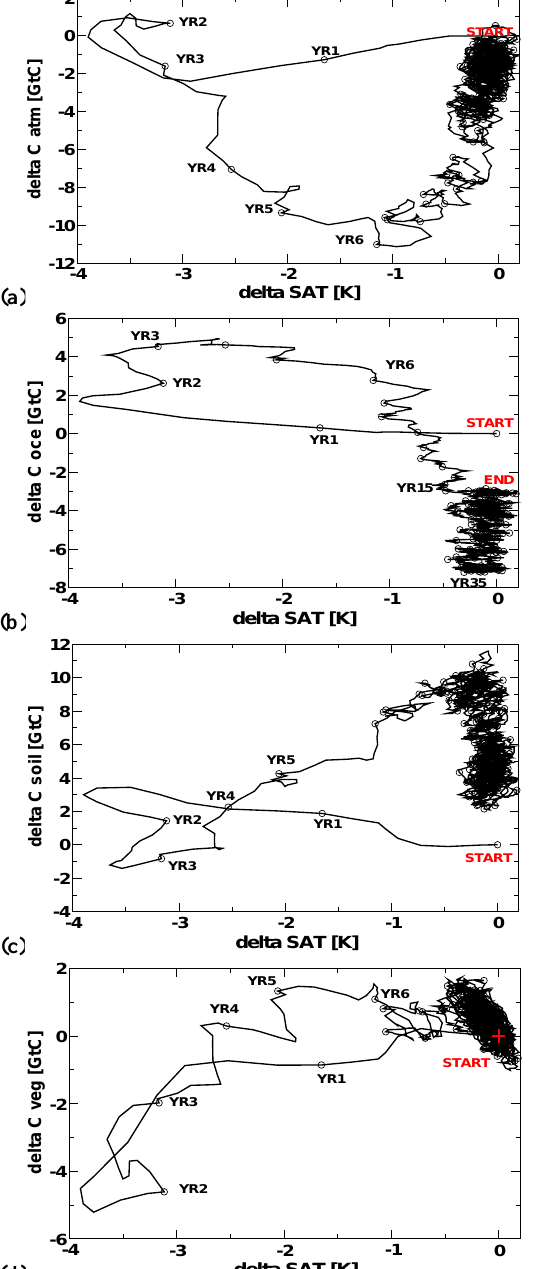
Fig. 10. Plots of ensemble mean SAT anomaly vs. ensemble mean anomaly of the carbon contents of (a) the atmosphere, (b) the ocean, (c) the soil, and (d) the terrestrial vegetation for 200yr. Time infor- mation is given by circles at the end of each year and annotated for selected years. Note the different scales in the panels.